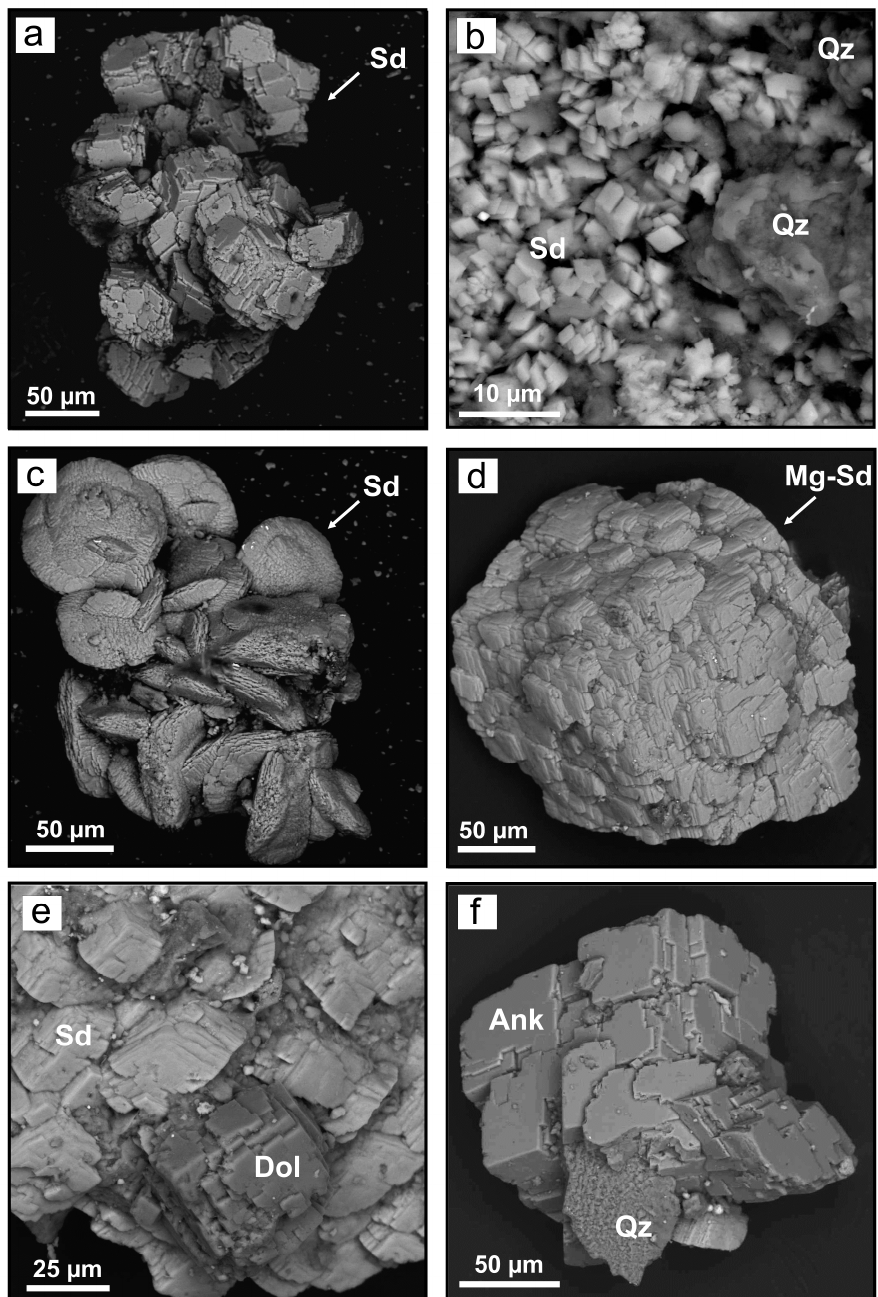
Figure 6. Morphology of authigenic carbonates from mud masses (Bulganak area). ( a ) Large rhombohedral crystals of siderite with rough faces and distinct growth steps; ( b ) Intergrowth of fine-grained siderite and quartz. Siderite forms tiny rhombohedral crystals with flat faces and well-defined edges and corners. Quartz exists as clots with uneven surface or as cement filling voids between siderite grains; ( c ) Foliated rhombohedrons of siderite; ( d ) Large rhombohedral crystal of Mg-siderite with intricately sculptured faces laminae and smoothed edges and corners; ( e ) Intergrowth of rhombohedral siderite and dolomite; crystals have rough faces with distinct growth steps; ( f ) Rhombohedral ankerite crystal with rough growth steps. Ankerite forms intergrowth with quartz. Back-scattered electron (BSE) images. Ank = ankerite; Dol = dolomite; Mg–Sd = magnesian siderite; Sd = siderite; Qz = quartz. ( a , b ) = Tischenko Hill; ( c – f ) = Trubetskoy Hill.